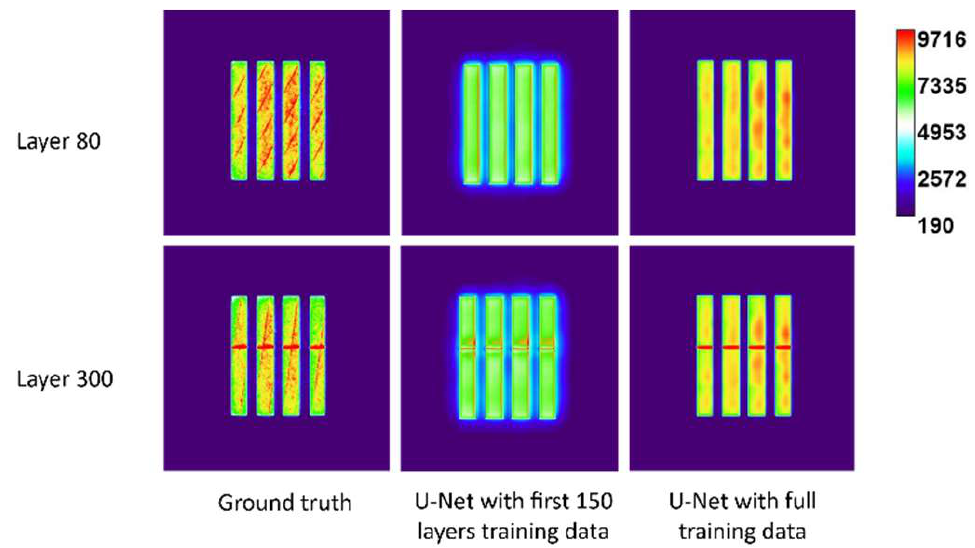
Figure 9. Prediction results by training data of the first 150 layers and full training data at layers 80 and 300.